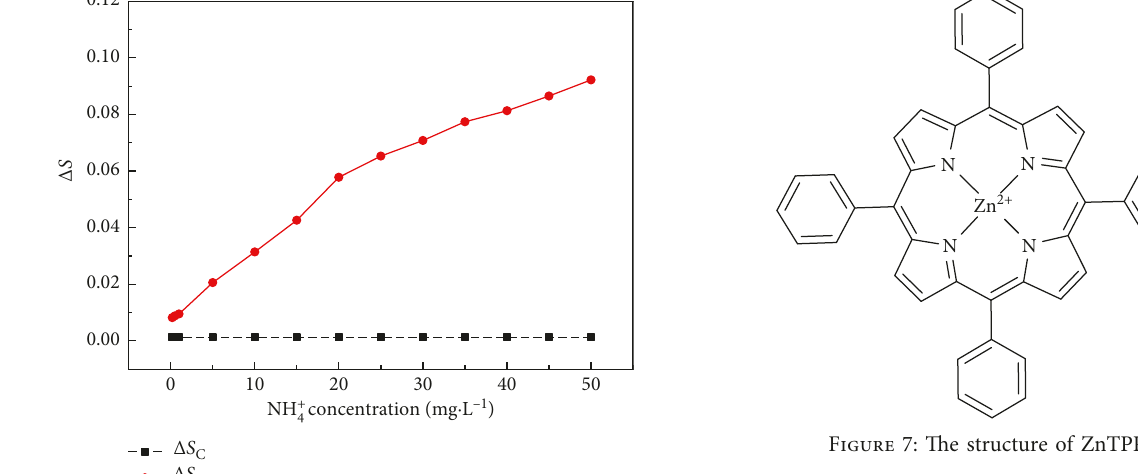
+ concentrations. 4